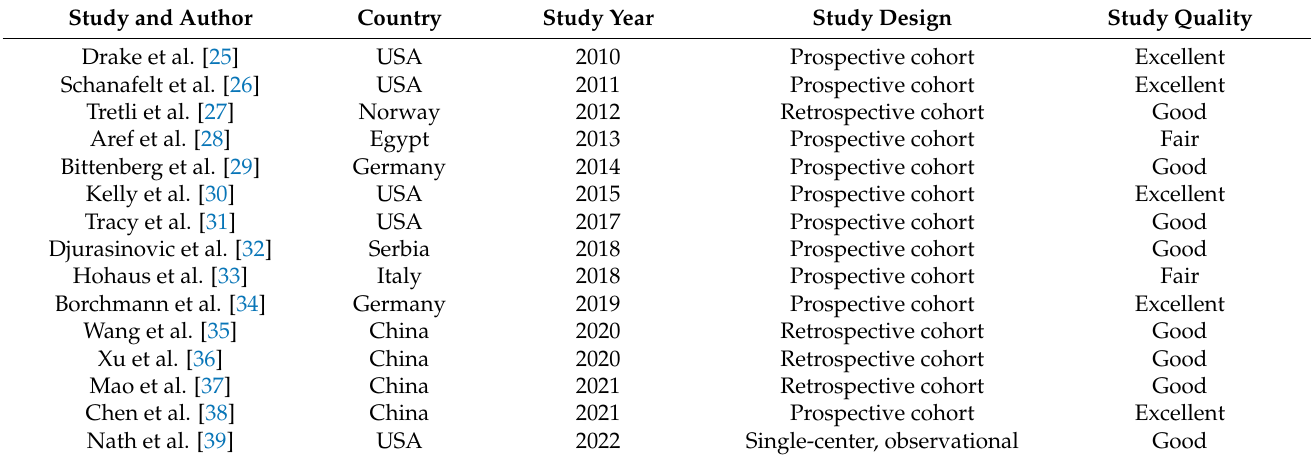
Table 1. Study characteristics.